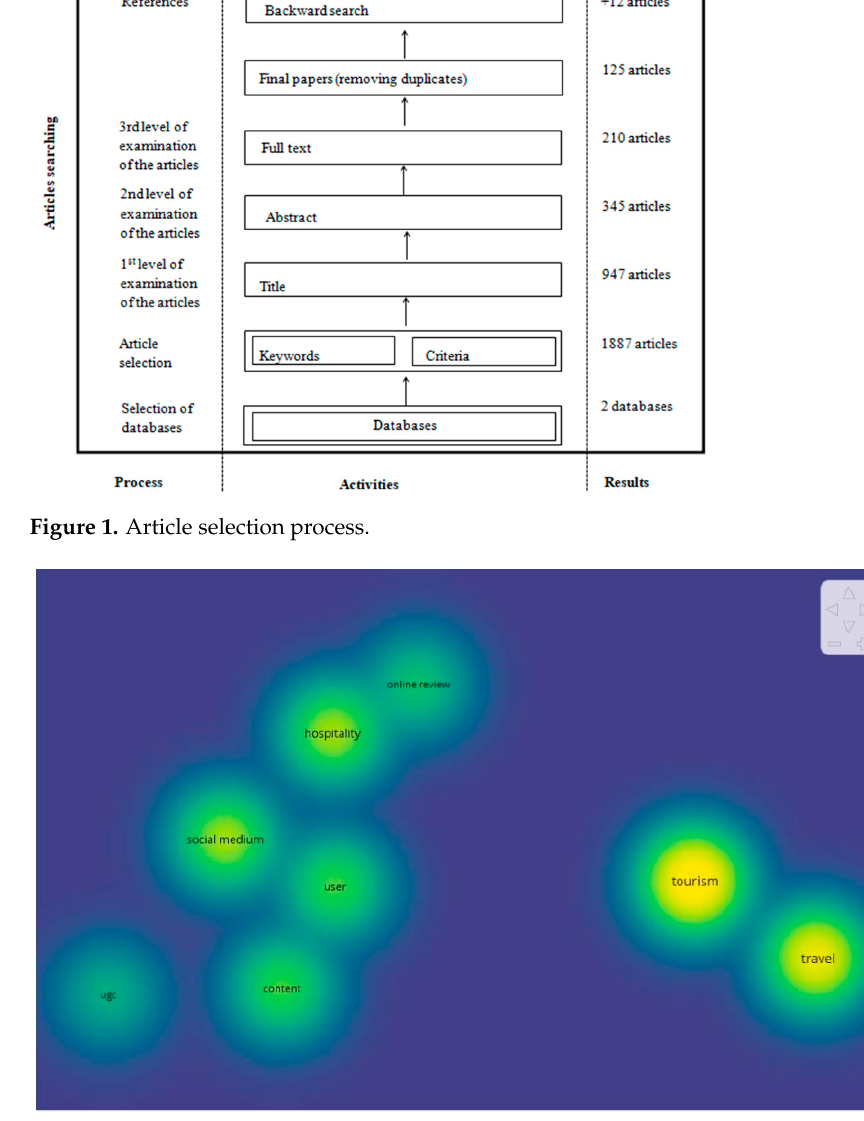
Figure 2. The heat map for the main concepts.